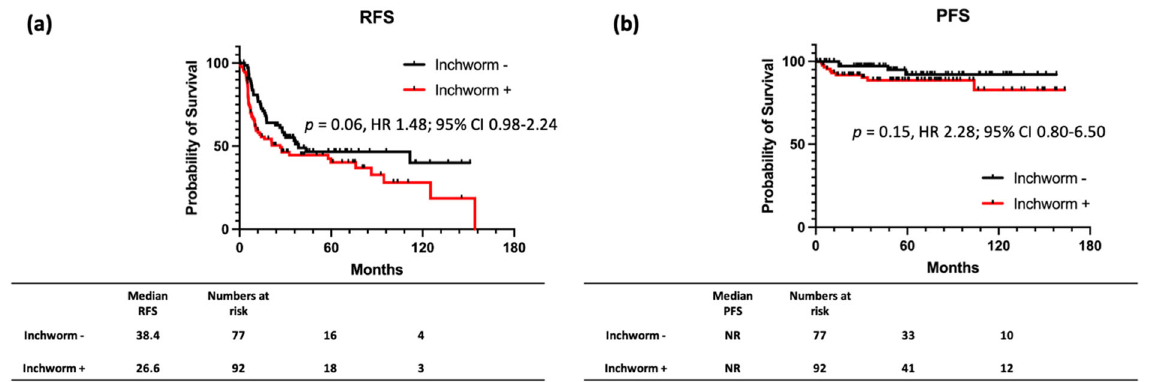
Figure 3. Kaplan − Meier survival curves for recurrence ‐ free survival. (a) Progression − free survival. (b) Stratified by the presence of inchworm sign for patients with NMIBC. Comparison of RFS (HR: 1.49, 95% CI: 0.98 − 2.27; p = 0.06) and PFS (HR: 1.92, 95% CI: 0.62 − 5.96; p = 0.28) between the negative and positive inchworm sign groups shows no significant difference.